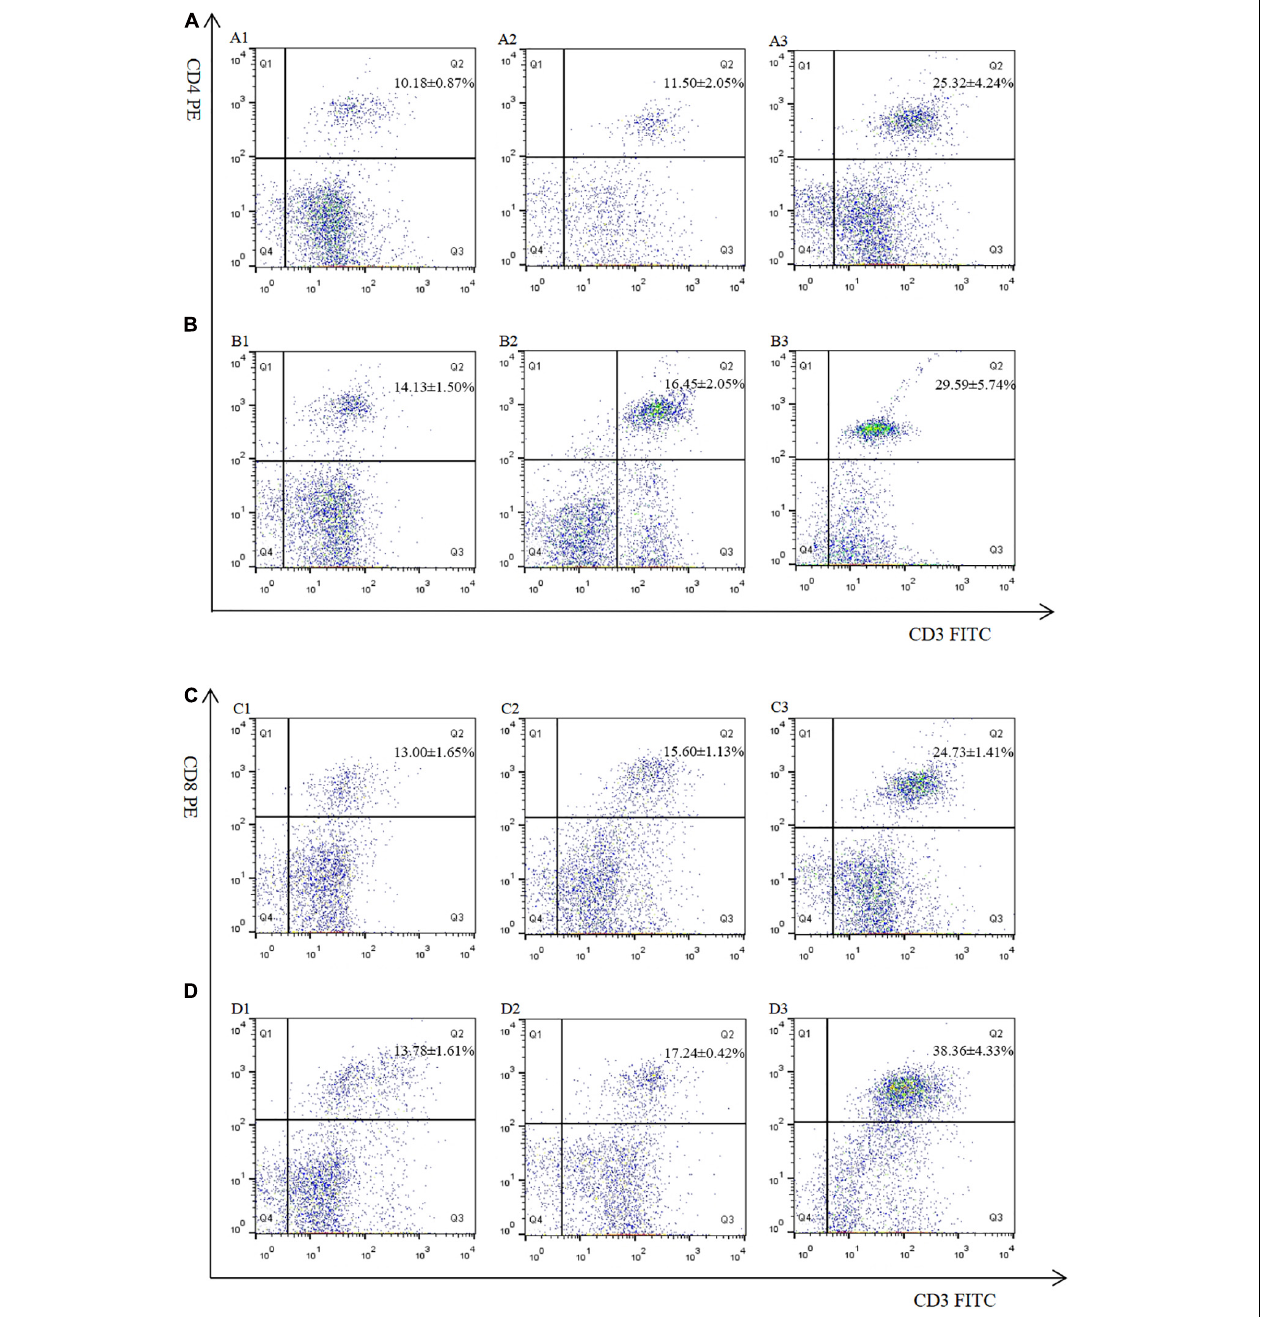
FIGURE 4 | Percentage of T cell subpopulation in the spleen of pVAX1-EmROM3 immunized chickens. N = 5, the data = mean ± standard deviation. (A) Detection of CD4 + /CD3 + T lymphocyte in immunized chicken spleen at 21 days old (7 days after the first immunization). (B) Detection of CD4 + /CD3 + T lymphocyte in immunized chicken spleen at 28 days old (7 days after the booster immunization). (C) Detection of CD8 + /CD3 + T lymphocyte in immunized chicken spleen at 21 days old (7 days after the first immunization). (D) Detection of CD8 + /CD3 + T lymphocyte in immunized chicken spleen at 28 days old (7 days after the booster immunization). 1: PBS (negative control). 2: Detection of T lymphocytes with immunized plasmid pVAX1. 3: Detection of T lymphocytes with immunized